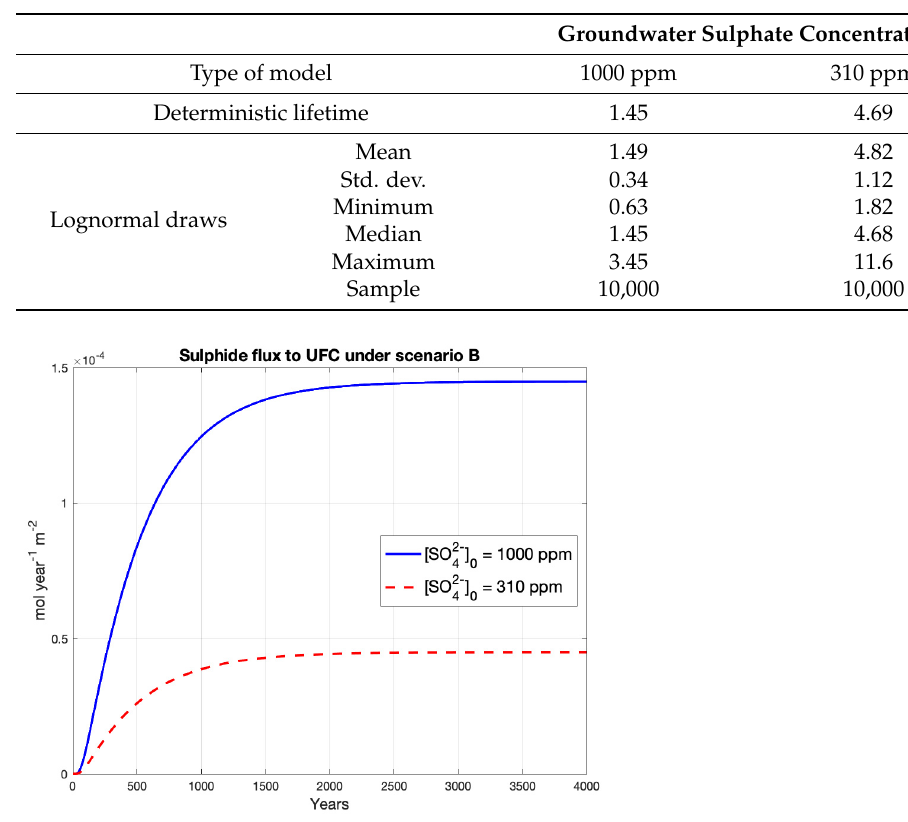
Figure 5. Histogram of UFC lifetimes under scenario B. 5. Sensitivity Analysis A sensitivity analysis is performed on the dry density of the gapfill bentonite and the optimal parameter 𝐶 (cid:3033) of Equation (10). These parameters are selected because they en- compass a level of uncertainty and their true value has a significant effect on the lifetimes of the UFCs. The gapfill bentonite is the material directly in contact to the host rock; therefore, its dry density determines the reduction rate at the rock interface and the mass transport to the HCB buffer box. For scenario A, the gapfill dry density is allowed to vary from 1300 to 1700 [kg/m 3 ] and the density of the HCB is kept at the design value of 1700 [kg/m 3 ].